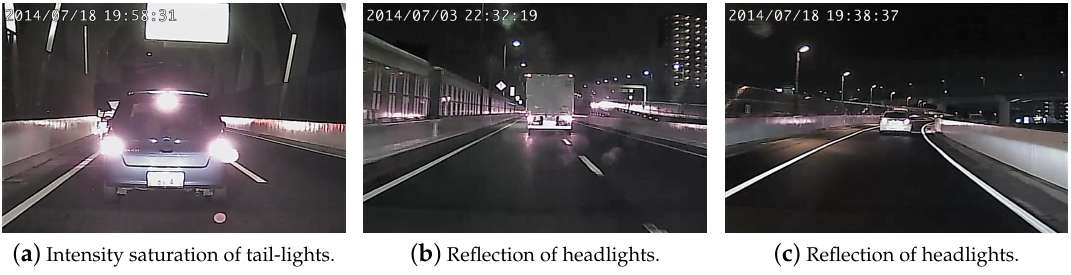
Figure 5. The nighttime images captured by the conventional low dynamic range driving recorder. The intensity saturation commonly appears due to the vehicle tail-lights and the reflection of headlights on the rear